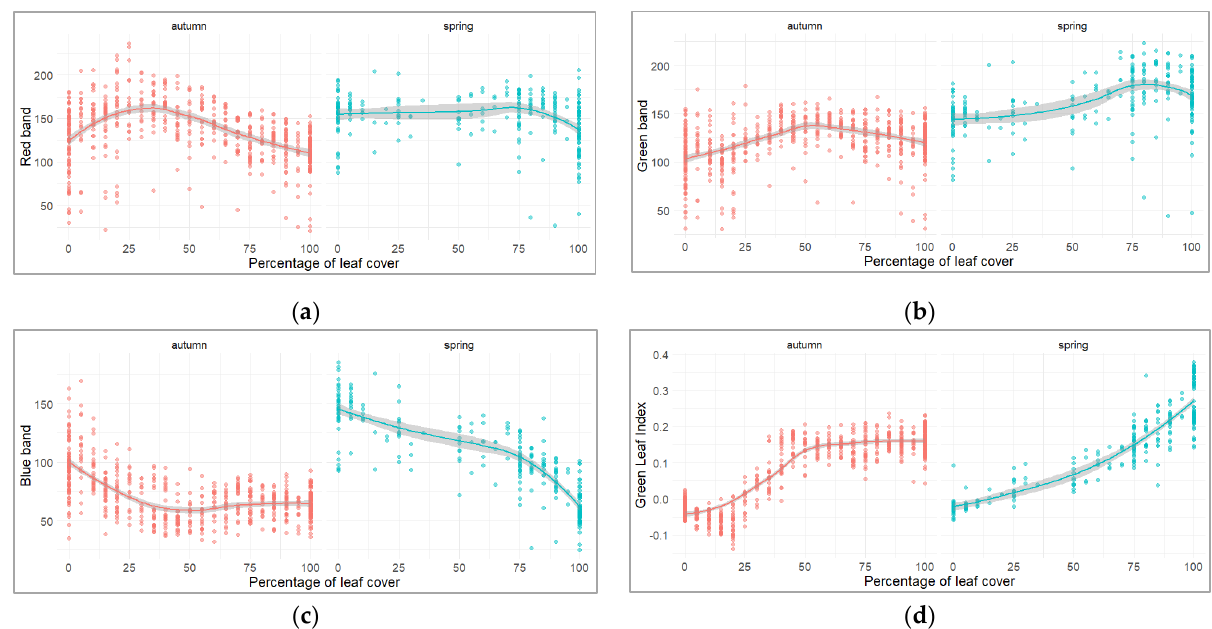
Figure 3. Relation between ground data observations, horizontal axis and ( a ) red, ( b ) green, and ( c ) blue spectral bands digital values, vertical axis, and ( d ) GLI among spring (blue color) and autumn (red color) seasons.